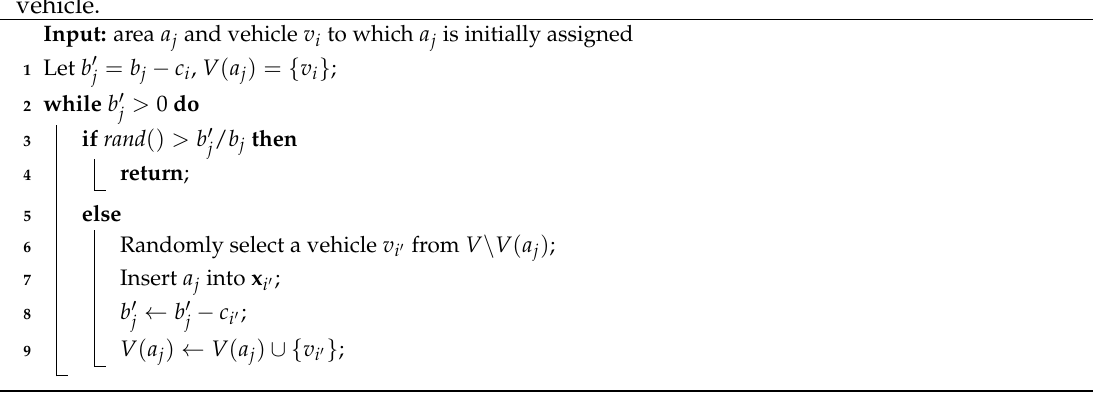
Algorithm 2: The procedure for assigning the individuals in an area to probably more than one vehicle.